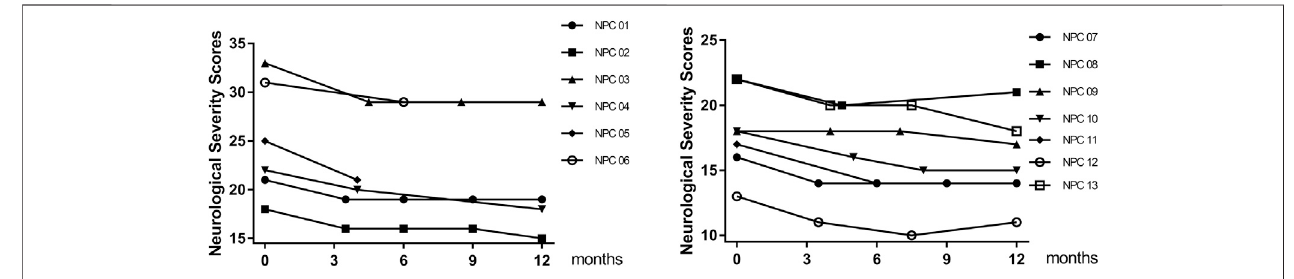
FIGURE 4 | Effect of lithium on NNSS. The total NNSS of 13 patients who accepted lithium treatment obtained at multiple time points within 12 months.